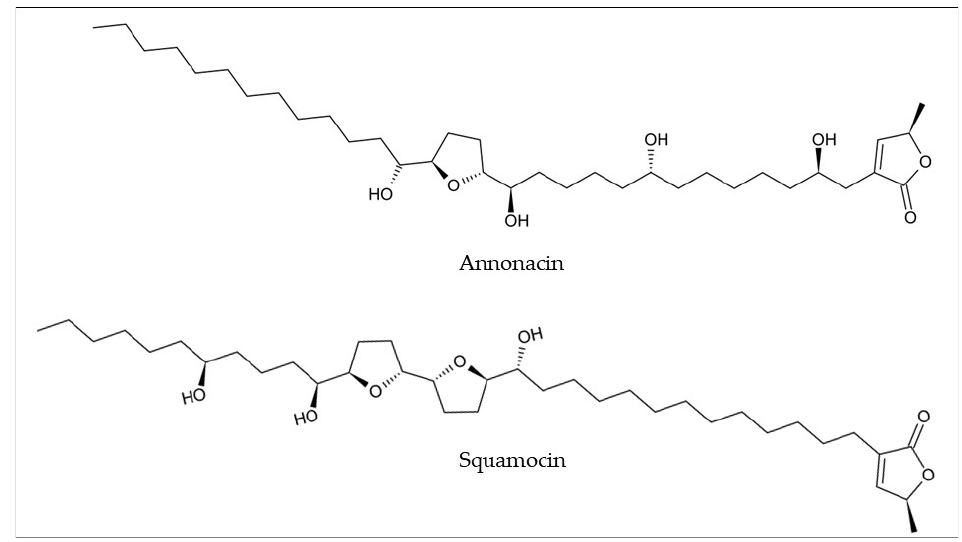
Figure 4. Chemical structures of the most common annonaceous acetogenins found in araticum fruit. Own authorship created by ChemSketch software.